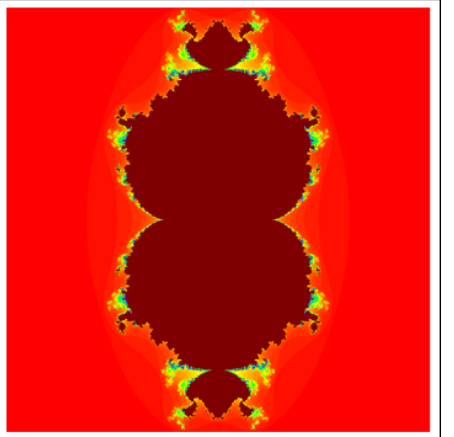
Figure 30. Third degree M-set via F-iteration with image visual time = 109.1 s.